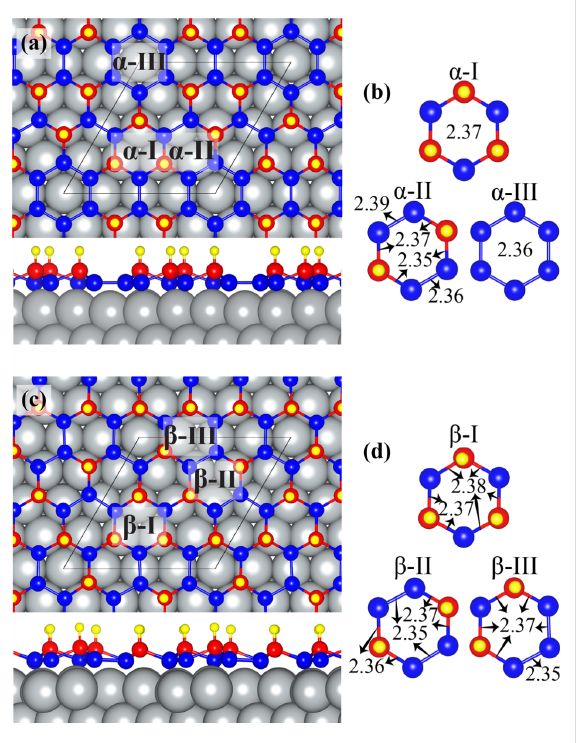
Figure 1: Top and side views of (a) H- α -Si and (b) its three different hexagonal units α -I, α -II, and α -III. Top and side views of (c) H- β -Si and (d) its three different hexagonal units β -I, β -II, and β -III. The 3×3 unitcells are represented by a black rhombus. Grey, blue, red, and yellow atoms show Ag, lower-Si, upper-Si, and H atoms,